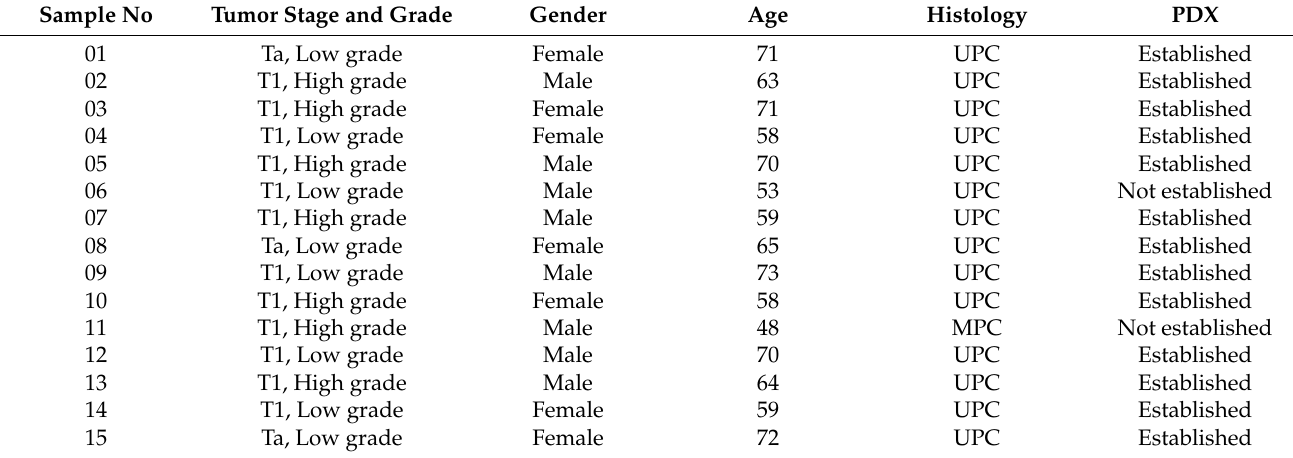
Table A1. Patients’ main gender characteristic and clinicopathological features of the tumors.